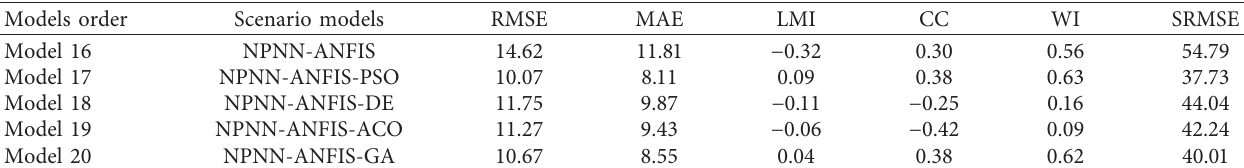
Table 5: The statistical evaluation of the developed hybrid and original ANFIS for the scenario of the non-preprocessed and nonnormalized (NPNN) dataset over the testing phase of the